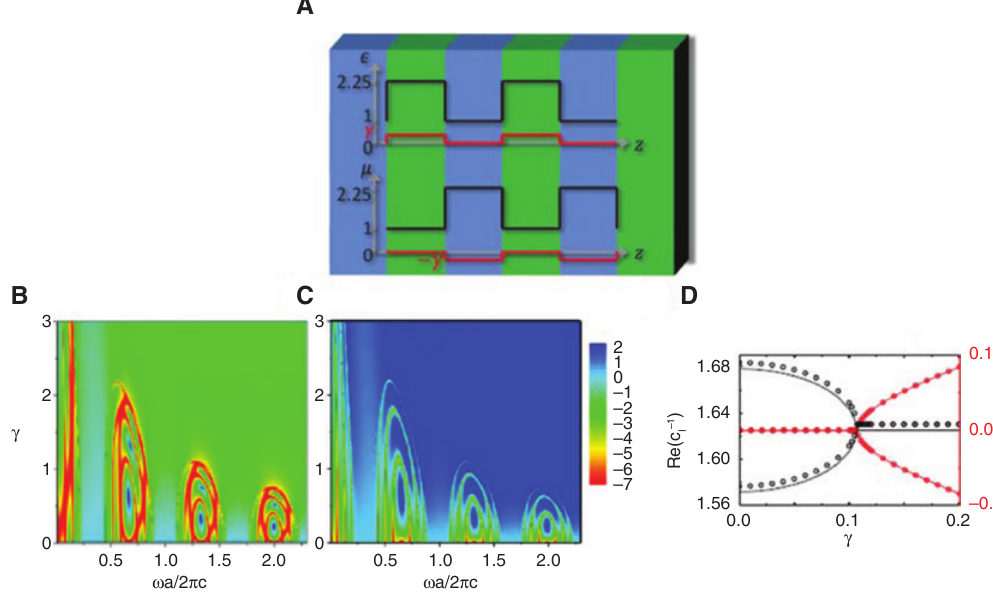
Figure 6: Unidirectional reflectionlessness of a PT -symmetric 1D PhC with cross-matching ε ( z ) to μ ∗ (− z ). (A) Permittivity ( ε ) and permeability ( μ ) profiles of a 1D PhC stacking alternating purely dielectric slabs with ε = 2.25 + i γ and purely magnetic slabs with μ = 2.25 − i γ with equal filling ratio and varying γ . (B) Forward and (C) backward reflectance (in natural log scale) for the PhC in (A) with a finite thickness of four unit cells. (D) Splitting of eigenvalues of the effective constitutive matrix C - 1 . The scattered symbols (solid lines) are the numerical results (analytical effective medium results)